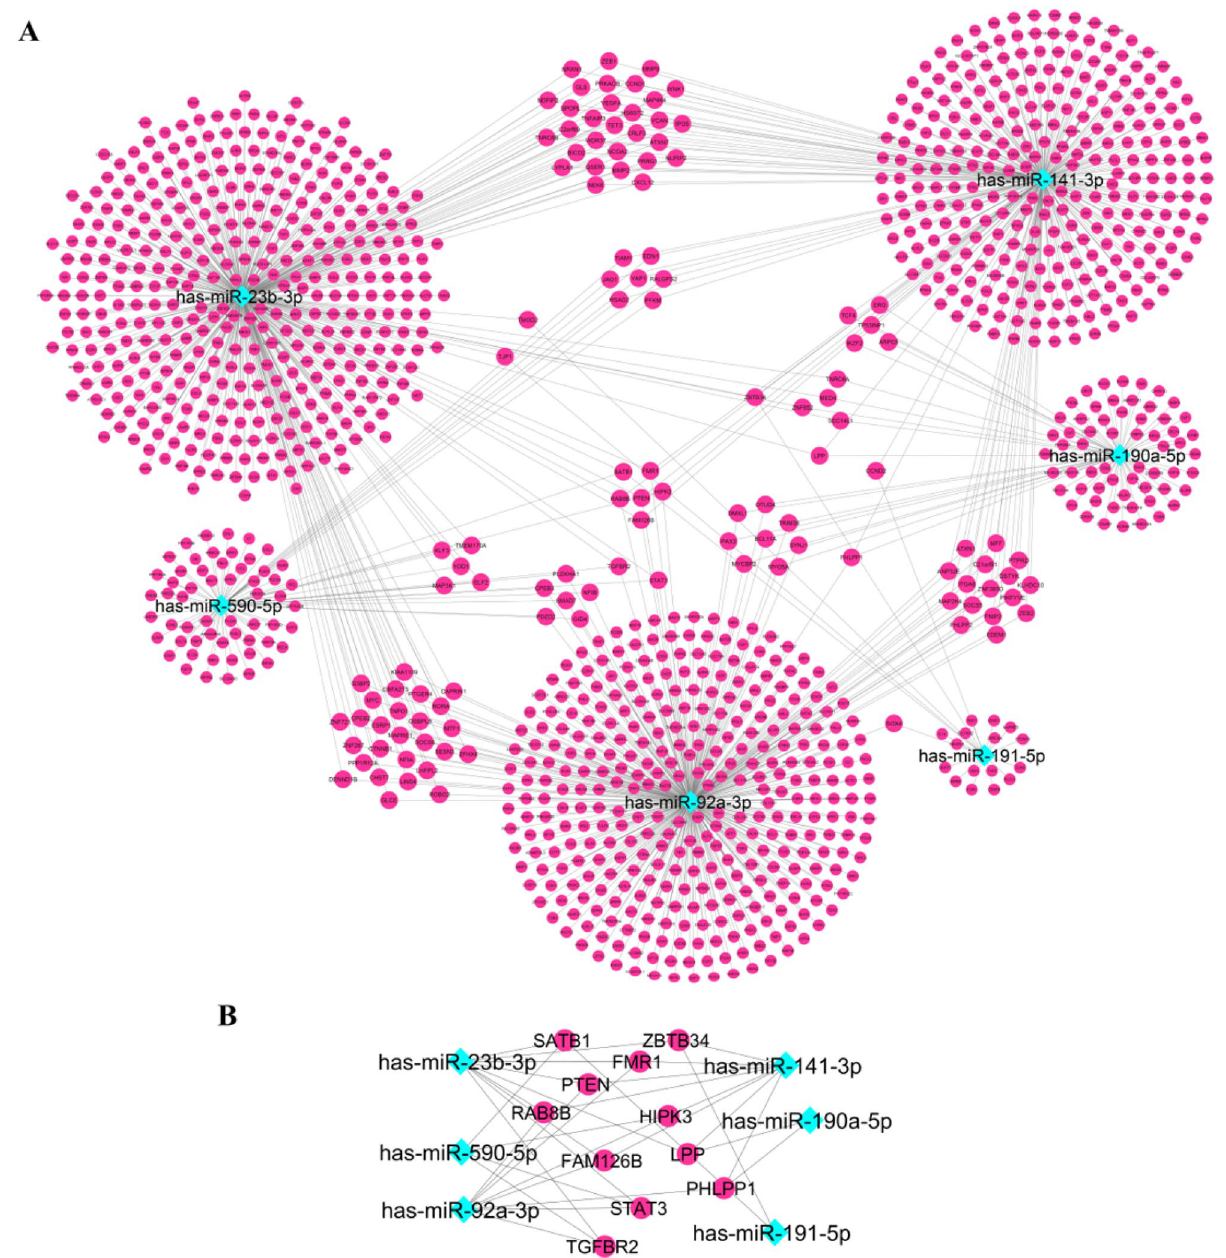
Figure 4. ( A ) The miRNA-target gene interaction network of the six final selected miRNA biomarkers and their computationally predicted/ validated target genes. ( B ) Genes targeted by three out of the six miRNA biomarkers, extracted from miRNA-target gen